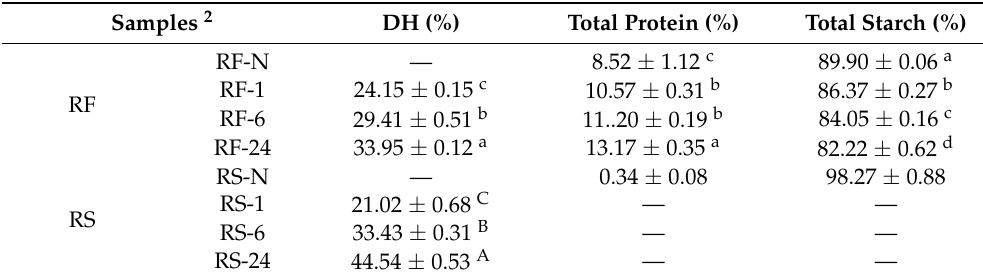
Table 1. The degree of hydrolysis (DH) and total starch and total protein contents 1 of native and partially RF and RS. Samples 2 DH (%) Total Protein (%) Total Starch (%)